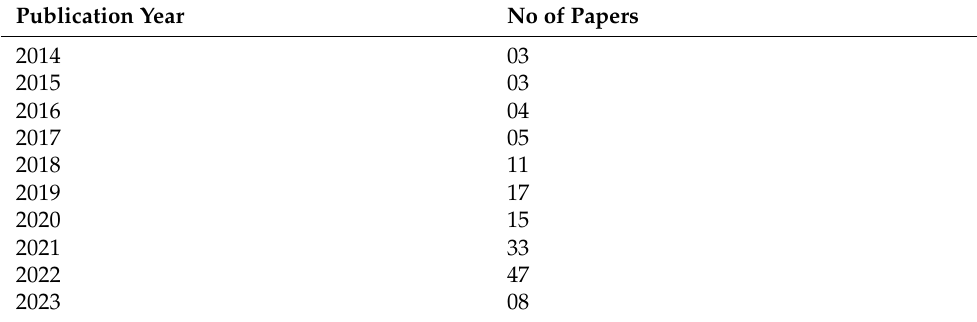
Figure 5. Search query. Table 5 shows the year-wise selection of papers. Table 5. Year-wise selection of